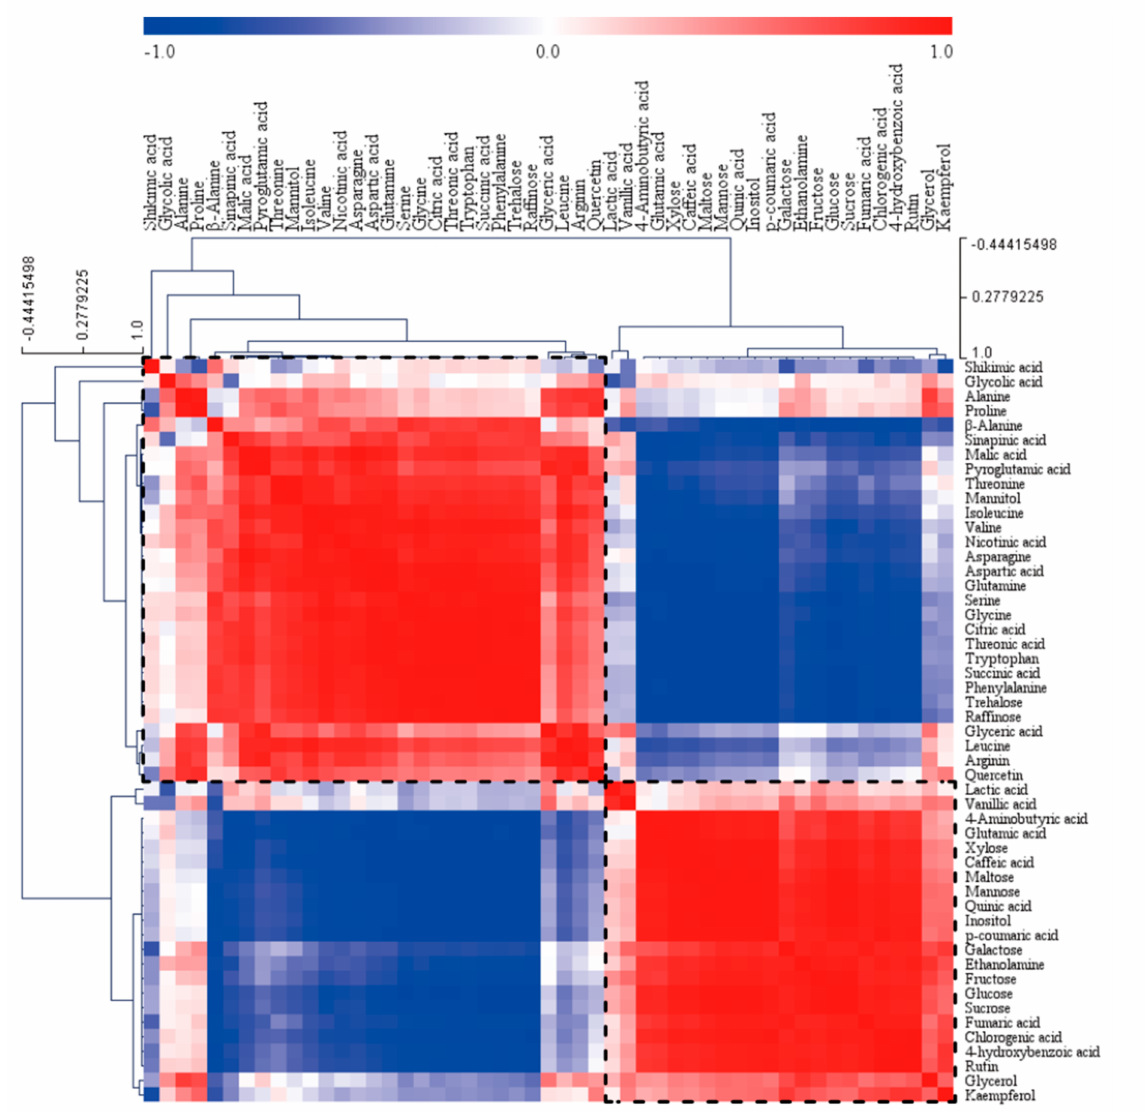
Figure 2. Correlation matrix of 51 metabolites from white flowers of M. denudata and violet flowers of M. liliiflora . Each square indicates the Pearson’s correlation coefficient of a pair of compounds, with the correlation coefficient indicated by the intensity of the red and blue colors. Dashed-line boxes indicate the 51 metabolites were clustered by an HCA using the Pearson’s correlation and average linkage